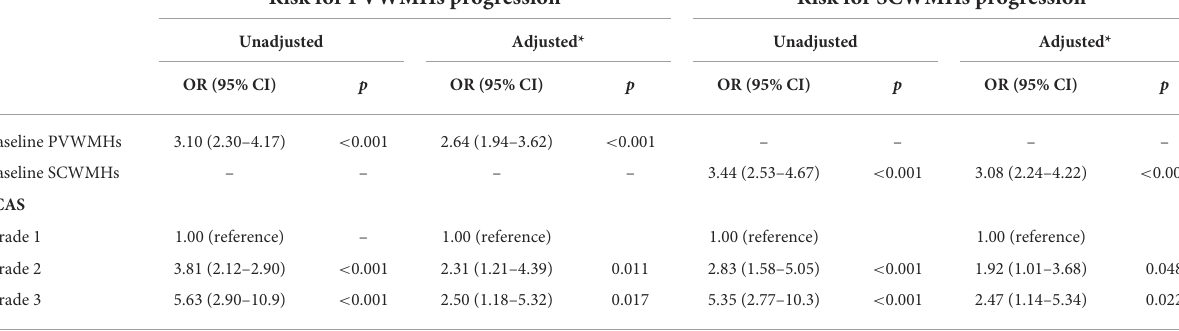
TABLE 4 Risk for progression of PVWMHs and SCWMHs associated with ICAS severity at baseline. Risk for PVWMHs progression Risk for SCWMHs progression